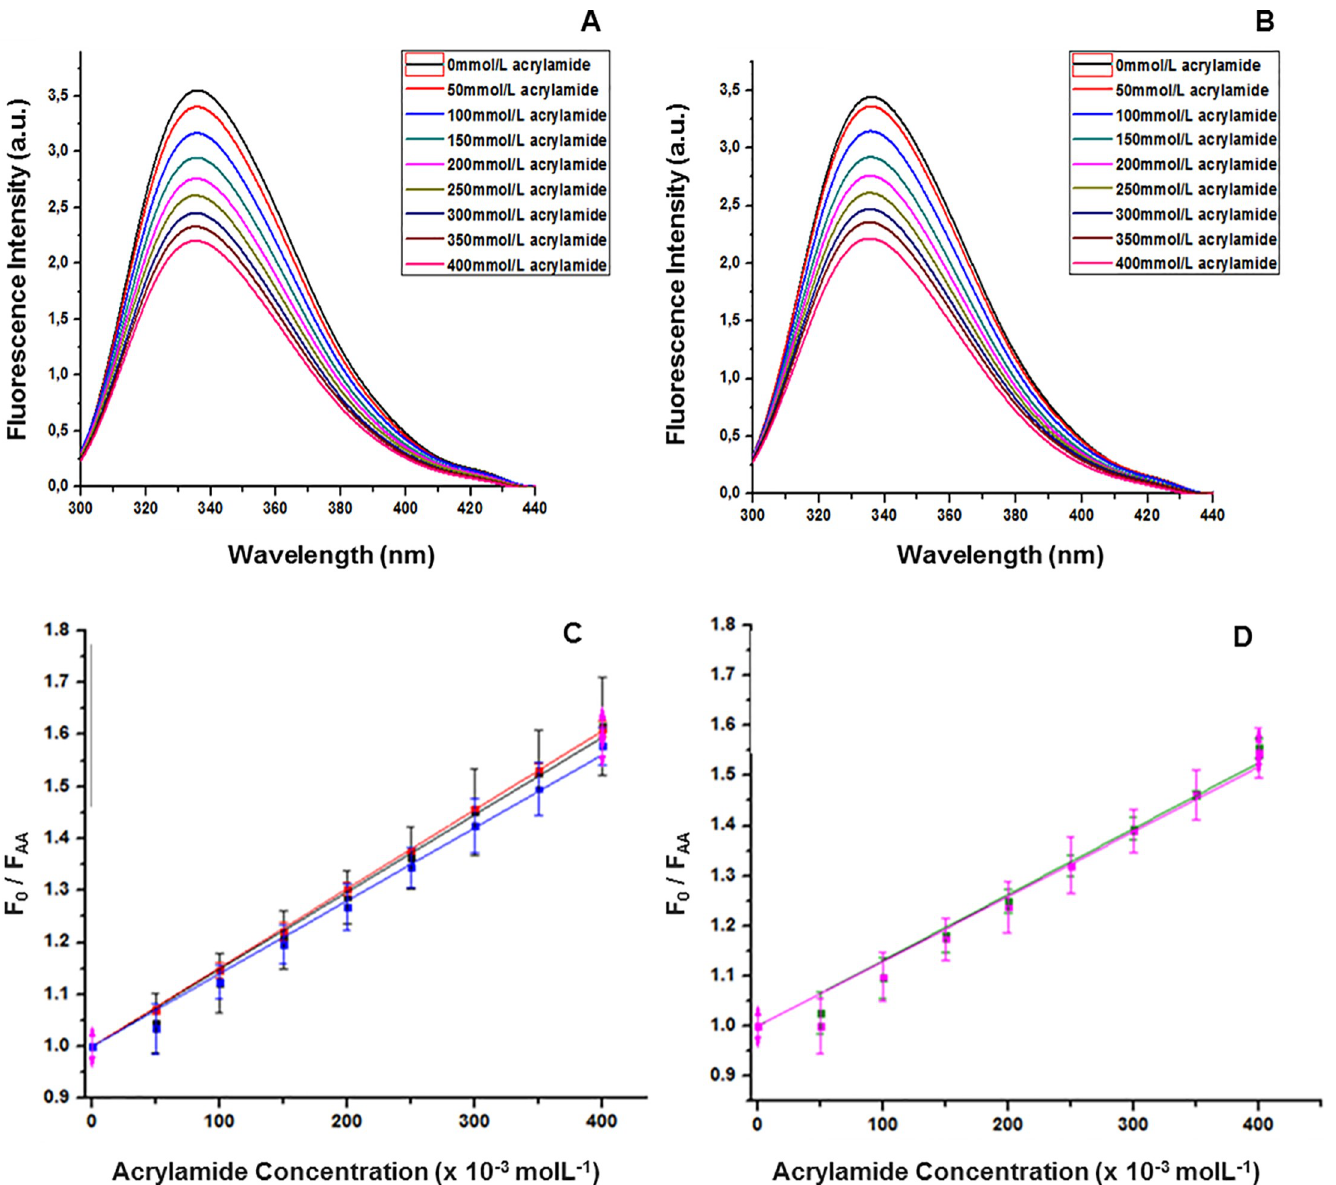
Fig 7. Degree of exposure of Trp residues. Fluorescence emission spectra of 5G4 mAb (A) and Herceptin (B) attenuated with different concentrations of acrylamide are shown. Black, red, light blue, yellow, dark blue, brown and pink colors spectra correspond to 0, 50, 100, 150, 250, 300, 350 and 400 mmol/L acrylamide. C and D: Stern Volmer representation for acrylamide attenuated 5G4 mAb and Herceptin. Different batches of each mAb are shown. 5G4 mAb batch 1 (black), 5G4 mAb batch 2 (red), 5G4 mAb batch 3 (blue), Herceptin batch 1 (green) and Herceptin batch 2 (pink).